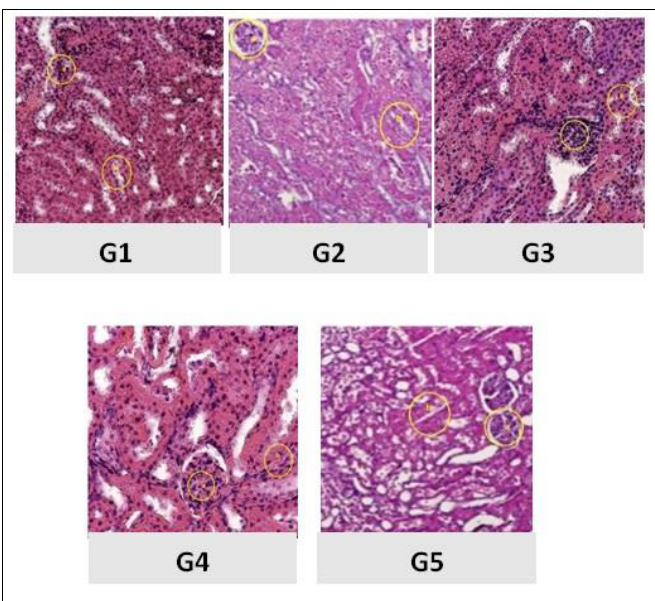
Figure 3: Histology of the kidney (40× objectives, scale bar 50 μm). G1: normal control, G2: negative control. G3, G4 and G5 were treated with 30, 60, and 120 mg/kg BW ethanolic extract of eleutherine americana merr, respectively.